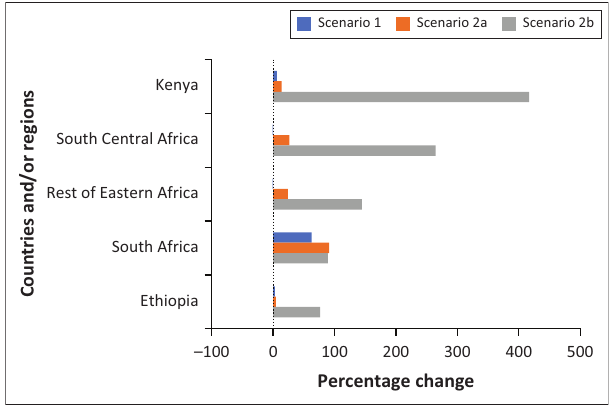
FIGURE 4: Summary of regional welfare changes in the top five performing countries/regions ( % change in US$) (ranked according to Scenario 2b results).